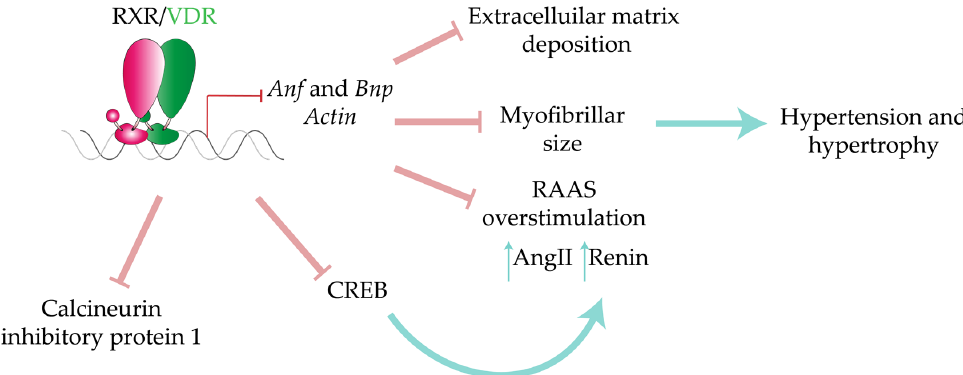
Figure 7. VDR anti-hypertrophic regulatory functions. Schematic representation of VDR/RXR modulation during pathological hypertrophy. Green arrows denote induction. Red arrows denote inhibition. RXR, retinoid X receptor. VDR, vitamin D receptor. RAAS, renin-angiotensin system. CREB, cAMP response element-binding. AngII, angiotensin II. Anf, atrial natriuretic peptide. Bnp, brain natruiretic peptide.